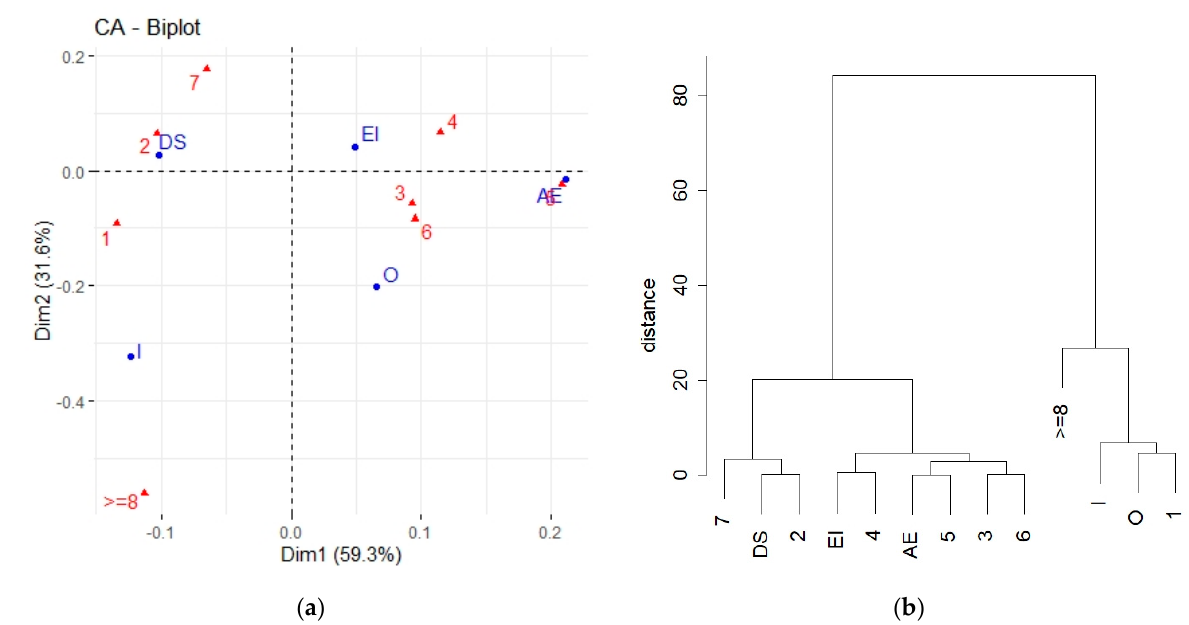
Figure 5. Correspondence map ( a ) and an auxiliary dendrogram ( b ) showing the dependence of each behavioural type of energy consumer on the number of persons in the household.